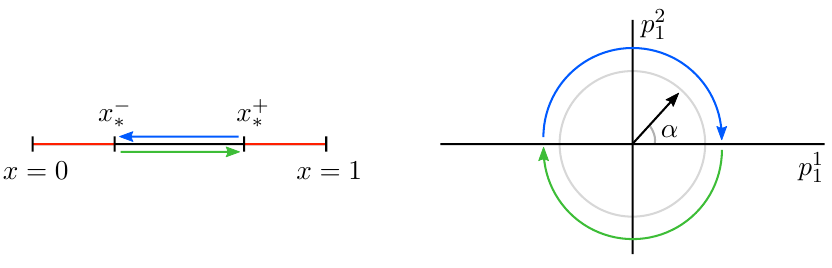
Figure 1 . Path of the angle α as x varies in the physical region [ x − region on the interval plays a role in the integral equation (1.9) or